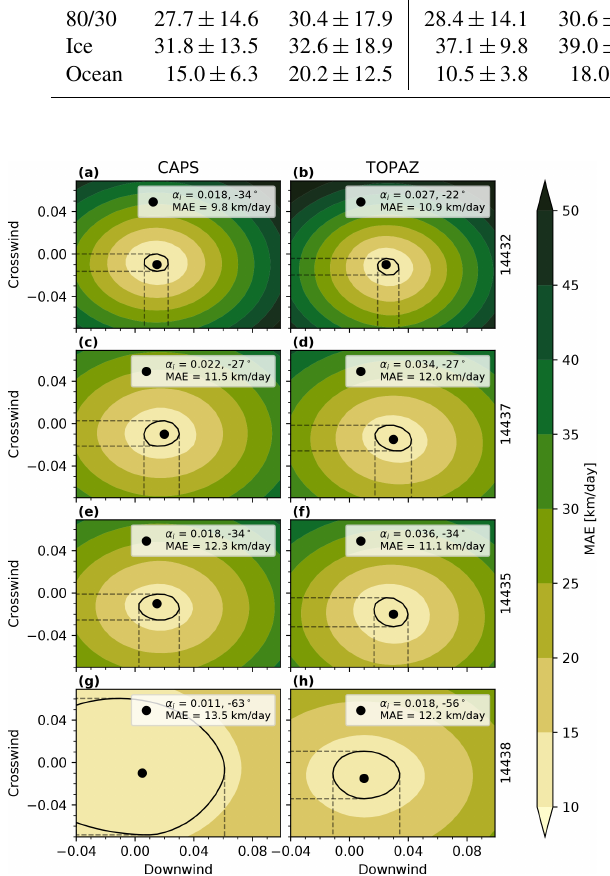
Figure 4. Filled contours of MAE (in kmd − 1 ) between observed drift velocities and Eq. (3) for the along- and cross-wind compo- nents of α i with α w = 0 . 03. The left column uses the CAPS forcing, and the right column uses TOPAZ forcing. The black dot shows the location of the MAE minimum, and the black contour line shows the MAE value within 1kmd − 1 of the minimum. Each row is for an individual drifter in order from high ice concentration at the top to low ice concentration at the bottom. Sensitivity to the choice of α i is much greater in the high ice concentration than the low.